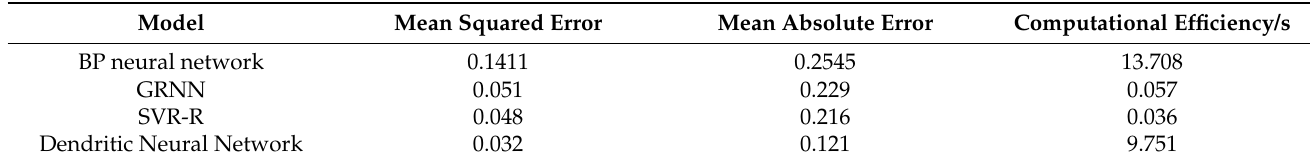
Table 5. Comparison of the DDNN with other